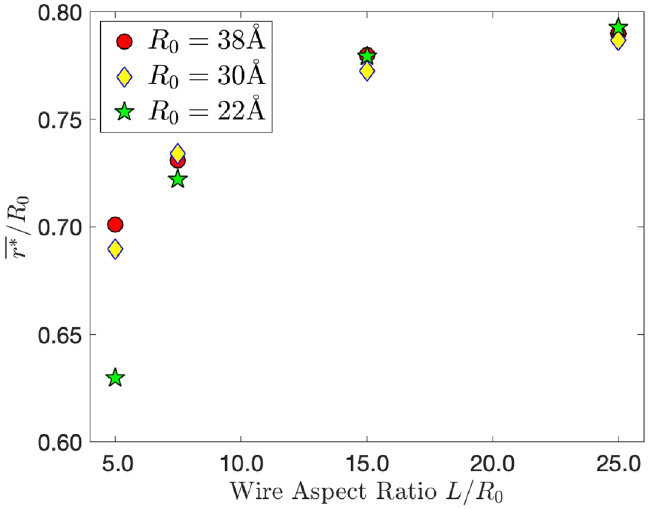
Figure 6. The ratio of equilibrium solid radius to initial wire radius against the wire aspect ratio. Values of r ∗ / R 0 for each aspect ratio are clustered closely together, where they begin to deviate markedly when the initial wire length L < 2 π R 0